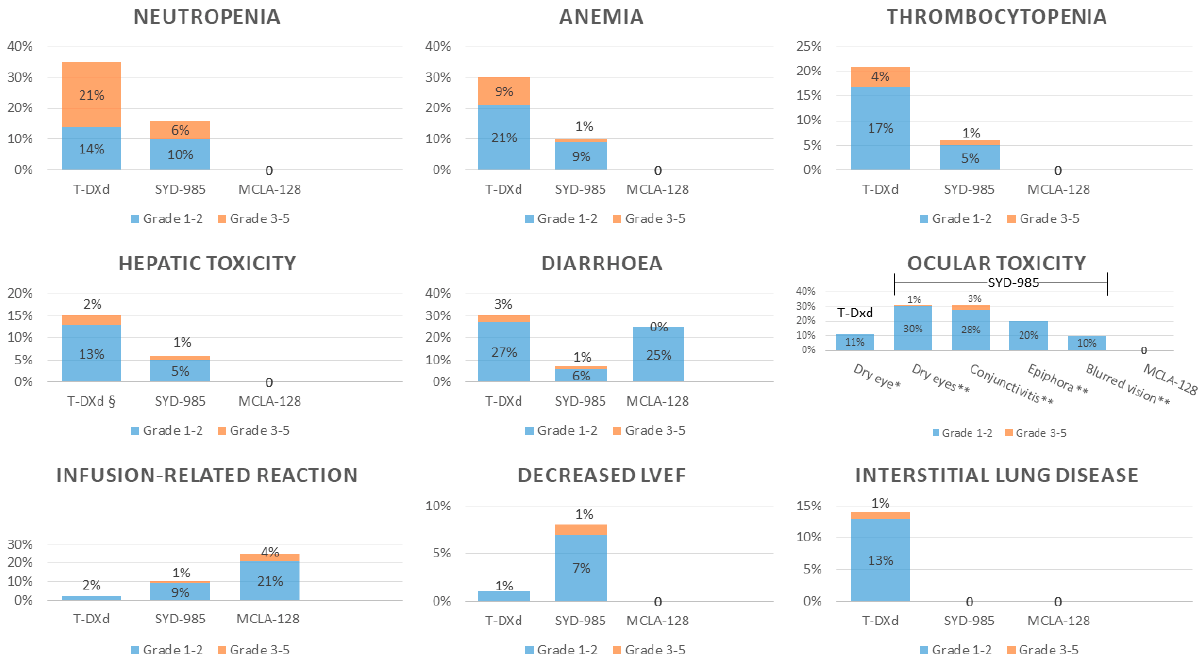
Figure 2. Incidence of key adverse events induced by trastuzumab–deruxtecan, trastuzumab–duocarmazine and zeno- cutuzumab. Abbreviations: T-DXd: trastuzumab–deruxtecan, SYD-985: trastuzumab–duocarmazine, MCLA-128: zeno- cutuzumab, LVEF: left ventricular ejection fraction. § Data extracted from all enrolled patients (dose-escalation and dose-expansion parts). * The only reported ocular adverse event was dry eye (data extracted from all enrolled patients (dose-escalation and dose-expansion parts)). ** other non-reported ocular adverse events include episcleritis (3%), corneal toxicity (1%) and retinal hemorrhage (1%).